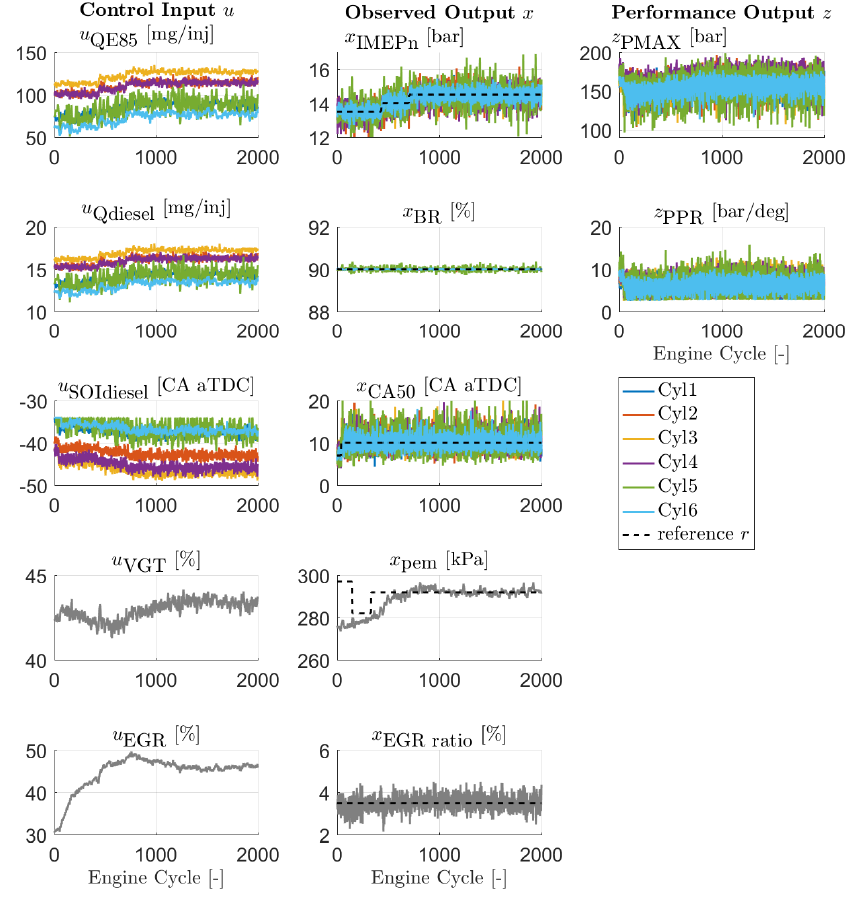
Figure 11. Engine load increase with closed-loop RCCI engine control (PFI-to-SPI E85 mass flow ratio of 50%:50%).